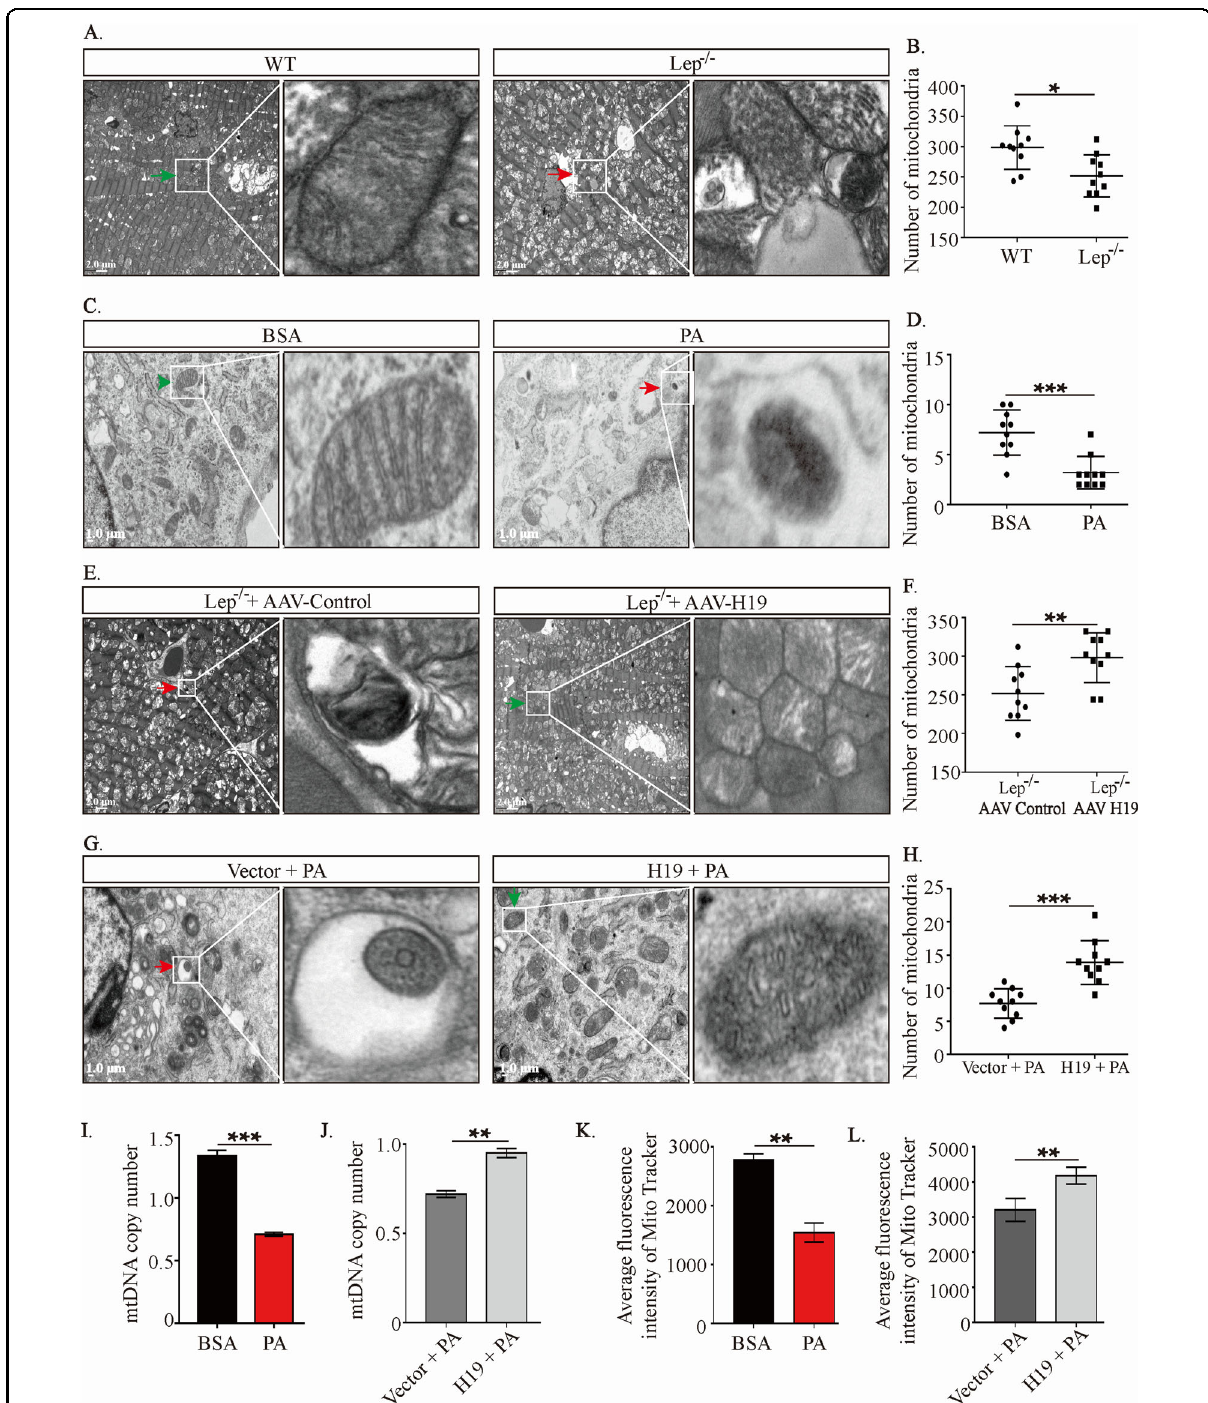
Fig. 2 Forced expression of H19 rescues cardiac mitochondrial mass reduction. A – H Morphologies and number of the mitochondria in H9c2 cell and left ventricular of mice detected by TEM under different treatments. Red arrows indicated autophagosomes or autolysosomes, including degraded mitochondria, while green arrows indicate normal mitochondria. The zoomed-in images represented high-magni fi cation views of the outlined areas. Ten images were obtained for each group. Scale bar: 2 μ m (in vivo) and 1 μ m (in vitro). I – L Effects of PA and H19 on mitochondrial number in H9c2 cells assessed by mtDNA copy number (detected by PCR) and MitoTracker ™ Green dye staining (detected by fl ow cytometry). Data in A – F are expressed as mean ± SEM. * P < 0.05; ** P < 0.01; *** P < 0.001. TEM, transmission electron microscope; BSA, bovine serum albumin; PA, palmitic acid; Lep − / − , B6-OB mice with leptin defects; WT, littermate control of Lep − / − ; H19, H19 overexpression; Vector, control lentivirus of H19; AAV, adeno-associated virus; mtDNA, mitochondrial